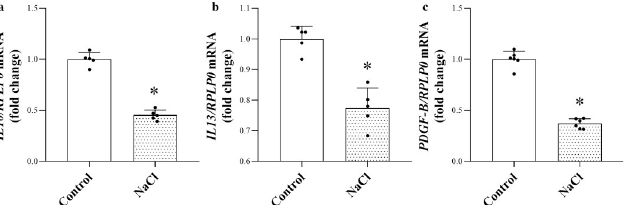
Fig 2. Effect of high NaCl environment on the anti-inflammatory and profibrotic cytokine production of human PBMC. ( a-b ) The mRNA expression of anti-inflammatory IL10 , IL13 and profibrotic PDGF-B were measured by real-time PCR in comparison with RPLP0 . Data were normalized and presented as the ratio of the mean values of the control group. Values were expressed as mean+SD. Dots represent individual values. n = 5 in each group; � p < 0.05 vs. Control (Unpaired t-test).